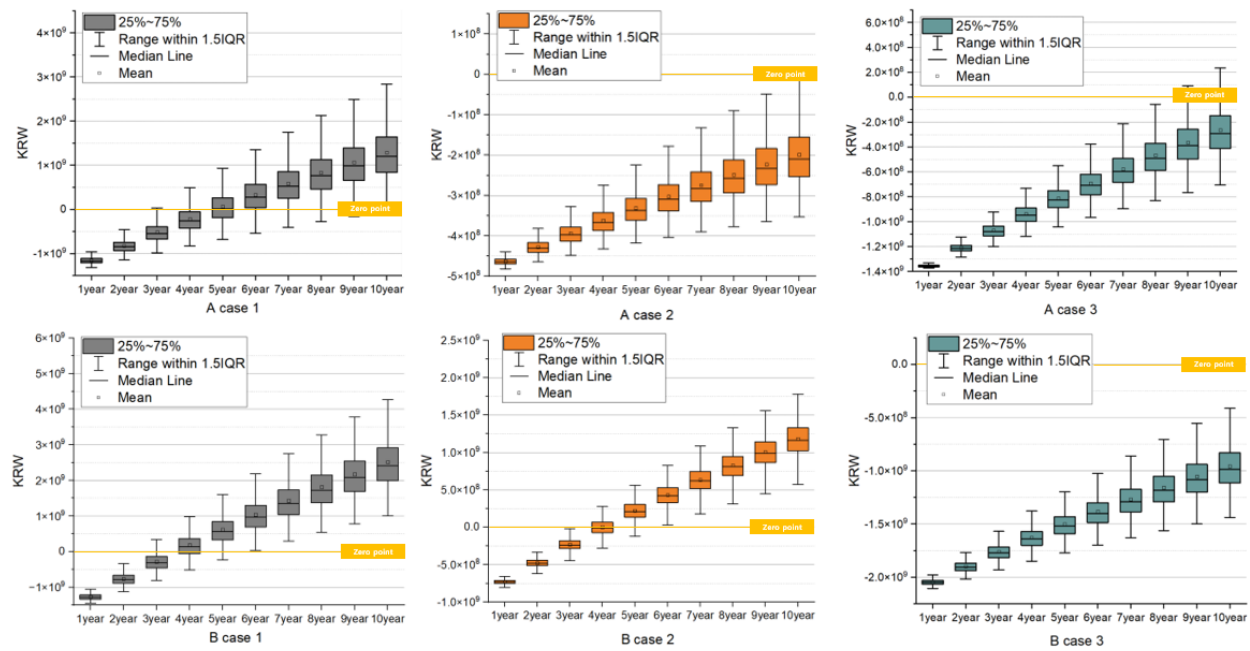
Figure 6. Carbon credits, and REC distribution.